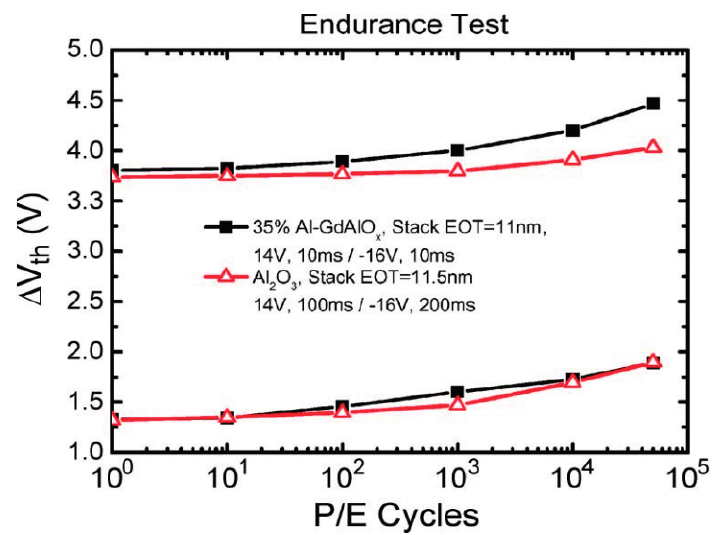
Figure 3. Endurance characteristic of 35% Al-GdAlO Reused with permission from [35], Copyright 1992,